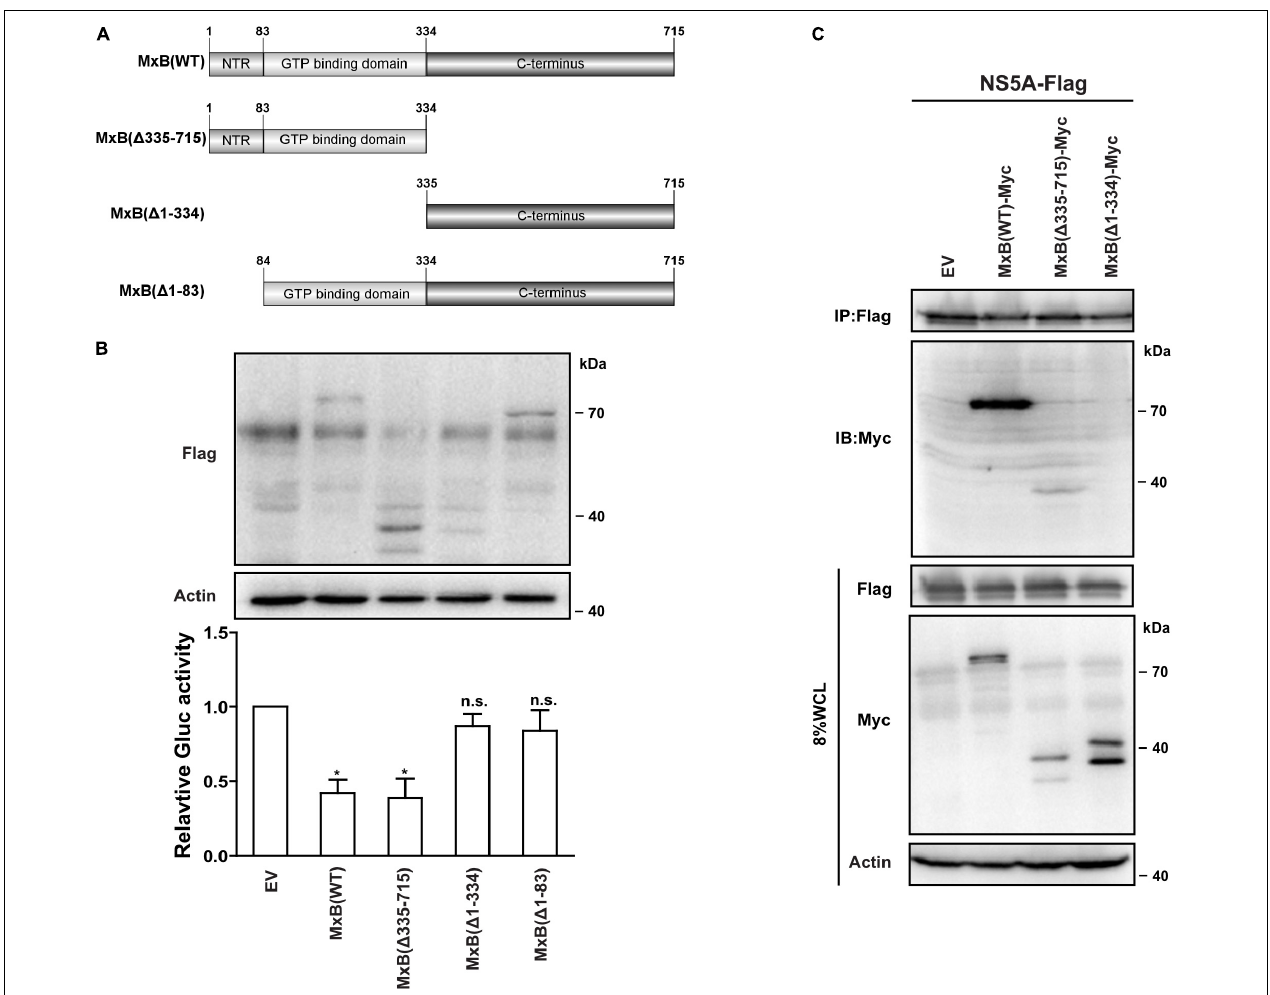
FIGURE 1 | The anti-HCV activity of MxB truncations. (A) Schematic representation of wild-type and mutated MxB. (B) The anti-HCV activities of MxB truncations. Huh7.5.1 cell line was transduced with plasmids expressing Flag-tagged MxB (WT) and MxB truncations. The expression levels were examined by Western blotting analysis. The Jc1 HCVcc virus, which expresses Gluc as a reporter, was used to infect the MxB Huh7.5.1 cells. HCV infection was determined by measuring Gluc activity in the supernatant. (C) Co-IP was applied to detect the interaction between MxB truncations and NS5A. HEK293T cells were transfected with plasmids expressing MxB-Myc truncations and NS5A-Flag. Anti-Flag antibody was used to pull down NS5A-Flag, and anti-Myc antibody was applied to detect MxB truncations. Data are representative of three independent experiments, and values are expressed as means ± SD. Difference between two conditions is considered statistically significant with p < 0.05 (*). n.s. indicates non-significance. HCV, hepatitis C virus; MxB, myxovirus resistance B; WT, wild-type; Co-IP,